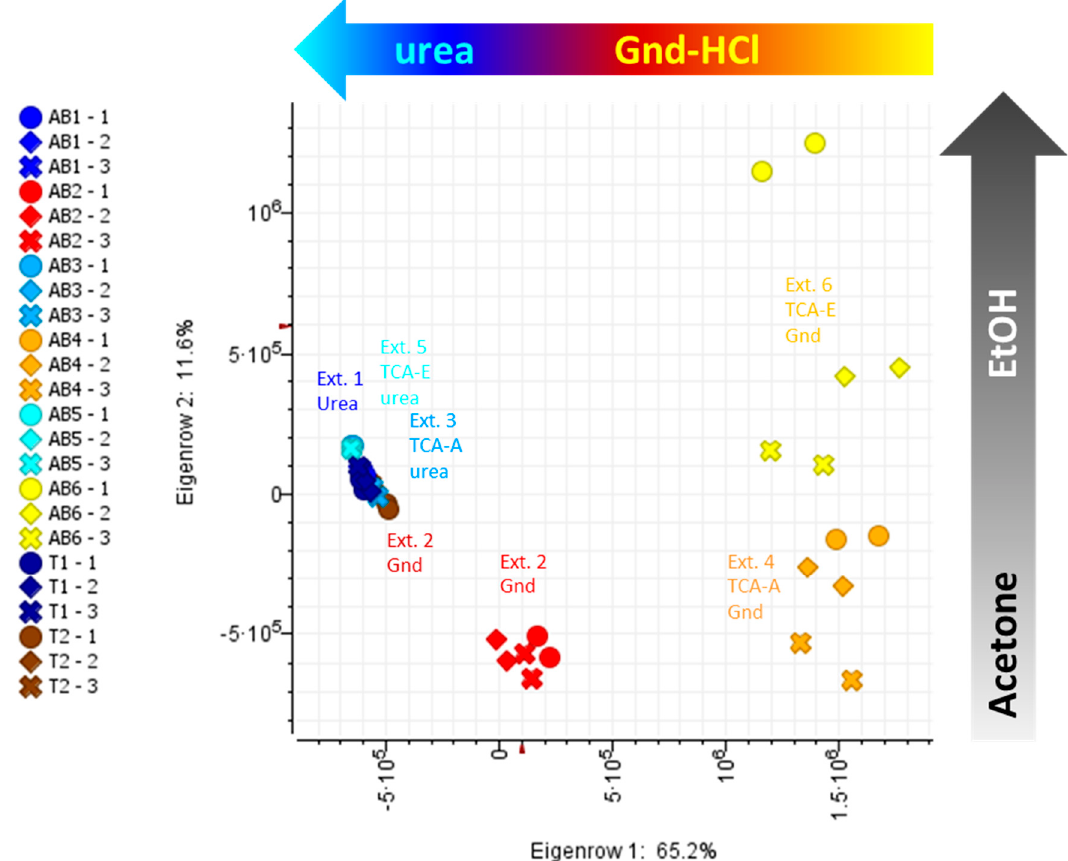
Figure 3. Principal component analysis (PCA) using bottom-up proteomics data. AB, apical buds; T, trichomes; 1–6, extraction methods 1 to 6. For details on extraction methods (AB1-6 and T1-2) refer to Figure 1.